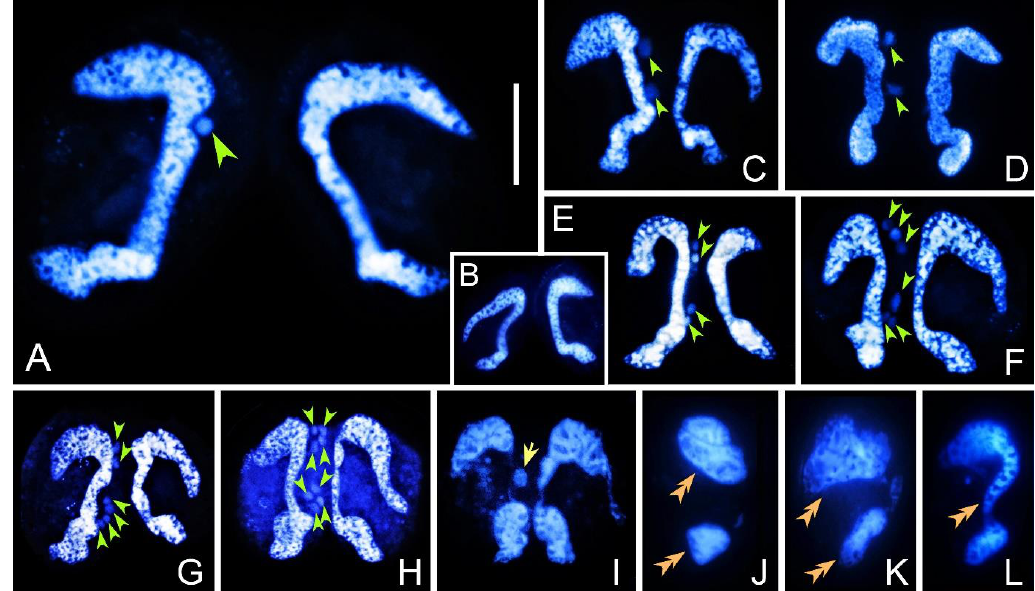
Figure 3. Nuclear events during conjugation of Euplotes raikovi amic cells pairing with amic or mic cells. ( A ) Mating pair between an amic and a mic cell. ( B ) Mating pair formed by two amic cells. ( C )